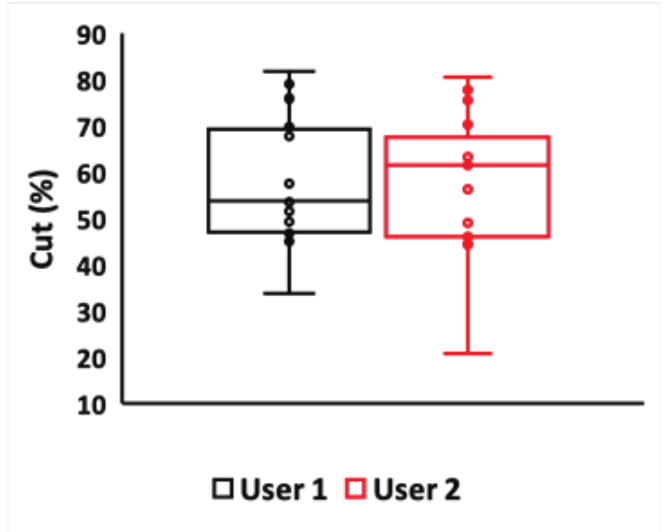
Figure 4. Comparison of corneal defects created by the inner-stopper guarded trephine by two users with different keratectomy experiences. User one had six months of experience in performing keratectomies and User two had one month of experience. There was no significant difference in the percentage of cornea excised between the two users.